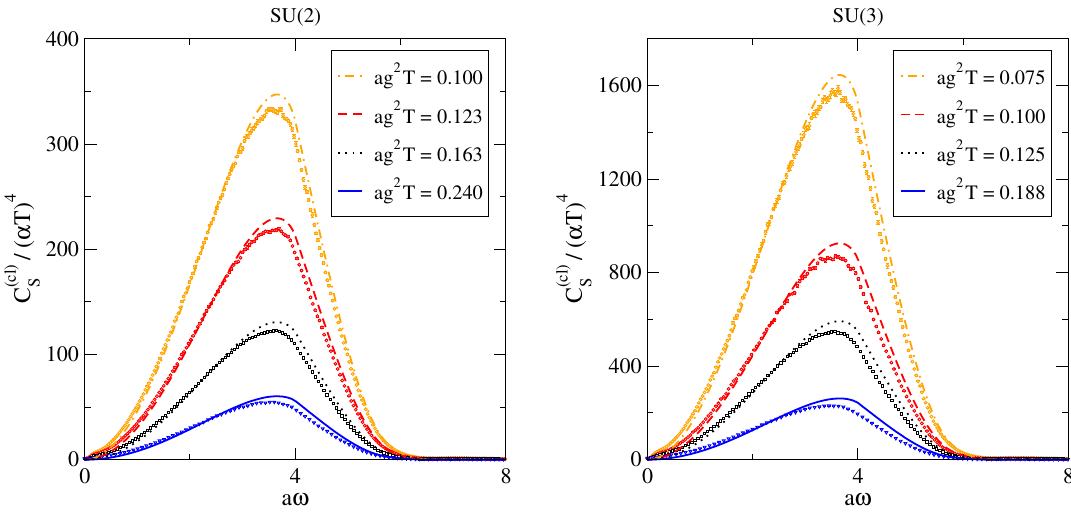
Figure 4 . Lattice data (open symbols) for C (cl) ( ω ) / ( αT ) 4 , with values of ag 2 T chosen from the S scaling regime (cf. figure 3), compared with the perturbative contribution from appendix A (lines). The latter is a fairly good approximation in the UV domain ω ∼ 1 /a , with the small discrepancy conceivably due to next-to-leading order corrections. Our physics conclusions come instead from the IR domain aω = ag 2 T × ω/ ( g 2 T ) < ∼ 1 . 3 , cf. figure 5, so we need to zoom very close to the origin to extract